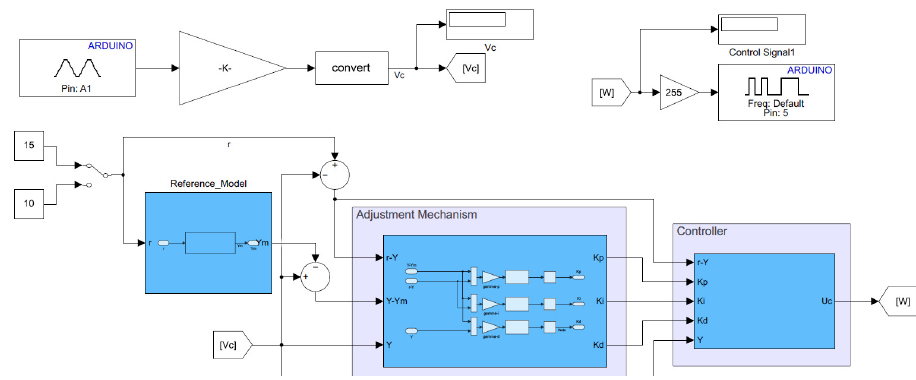
Figure 13. The designed Simulink to create an embedded system on Arduino Uno.